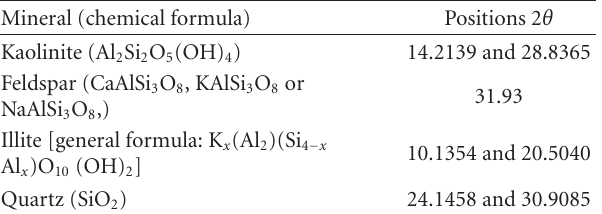
Table 6: Positions 2 θ for minerals in the silt fraction of the sediment collected at sampling point 3, in March of 2007 [25–27].